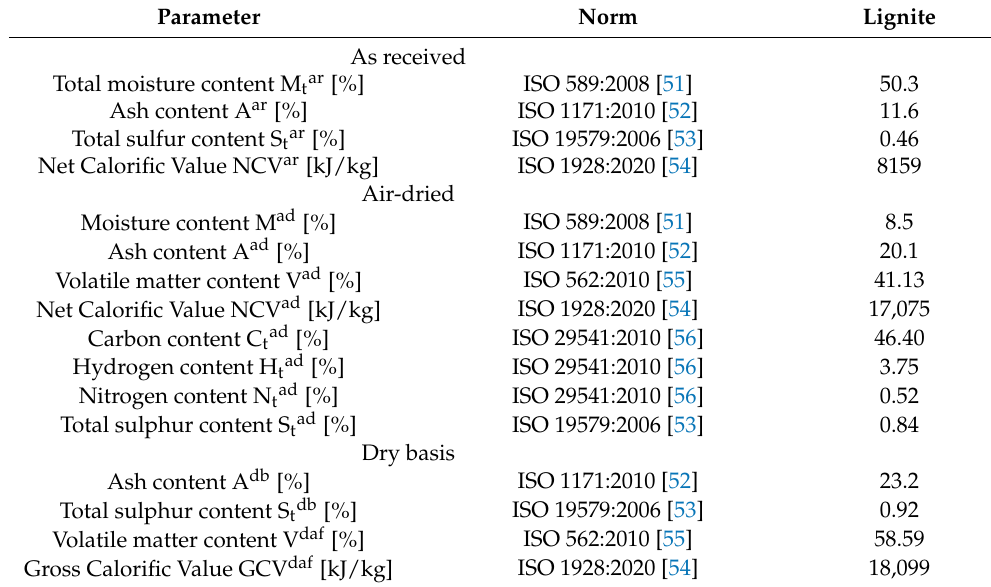
Table 1. Physico-chemical parameters of lignite from the “Szczerc ó w” deposit [50]. Parameter Norm